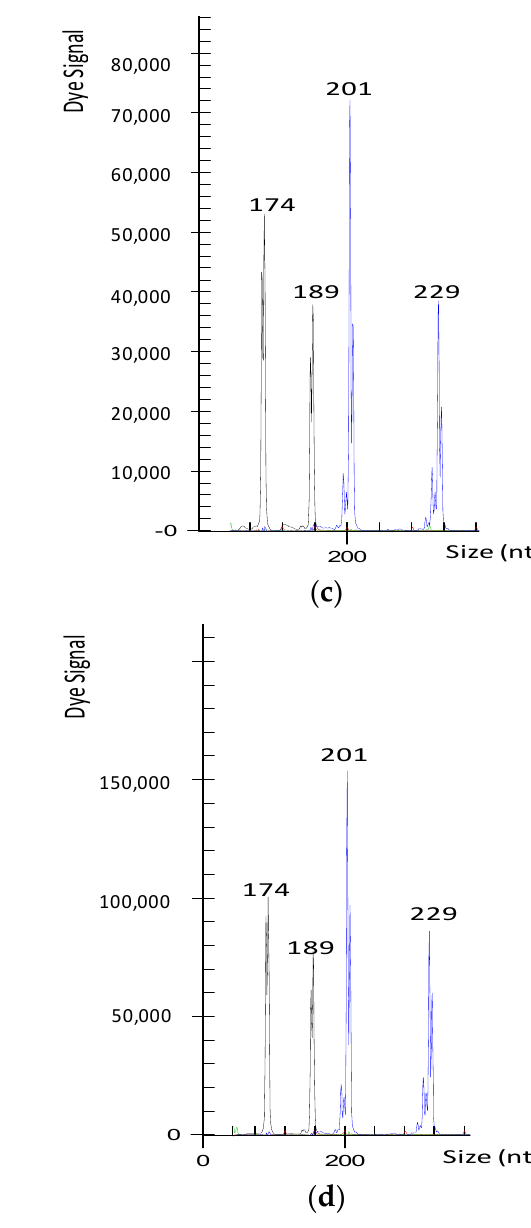
Figure 2. Electropherograms obtained using the mCrCIR05A05 (black) and mCrCIR03G05 (green) SSR markers for ‘Imperial’ mandarin ( a ), a diploid hybrid recovered from the self-pollination of ‘Imperial’ ( b ), the MEST15 (black) and Ci02D04 (blue) loci for ‘Ellendale’ tangor ( c ), and a diploid hybrid recovered from the self-pollination of ‘Ellendale’ tangor ( d ). Numbers indicate the size of alleles in nucleotides (nt) for each variety.